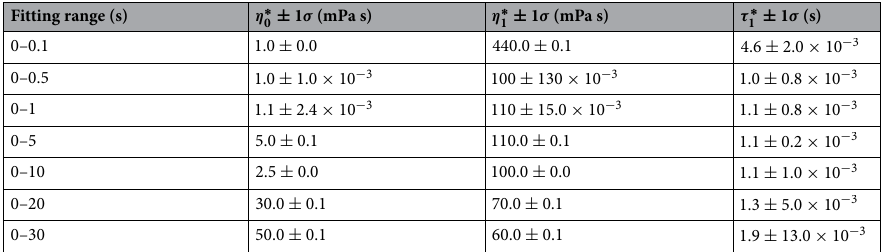
Figure 2. ACF for simulated time series of time step � t /τ S with the corresponding best fit and residue in the insets. Upper inset in each figure concentrates on the initial regions of the residuals which shows that the variance S of the model increases after a certain time